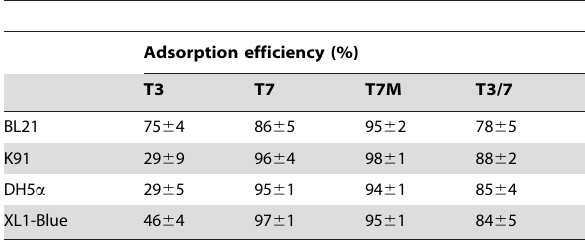
Table 2. Adsorption efficiency (%) of phages on E. coli female and male